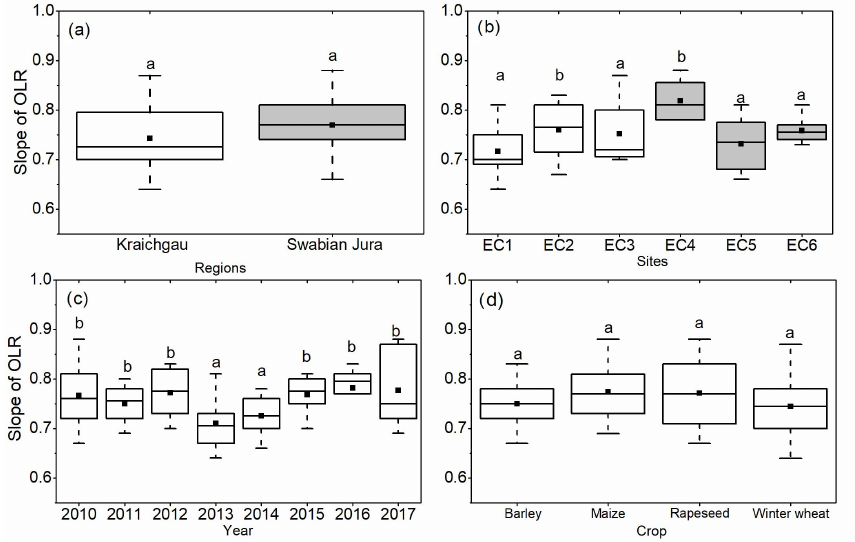
Figure 6. Comparison of energy balance closure (EBC) measured by linear regression, grouped for the different regions, sites, years, and crops. Measurements were conducted from early spring until harvest. Different letters indicate significant (a – insignificant, b – significant) differences between the factor levels at α = 0 .